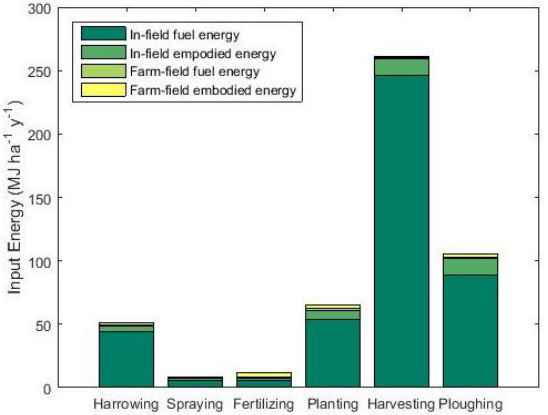
field-storage activities.